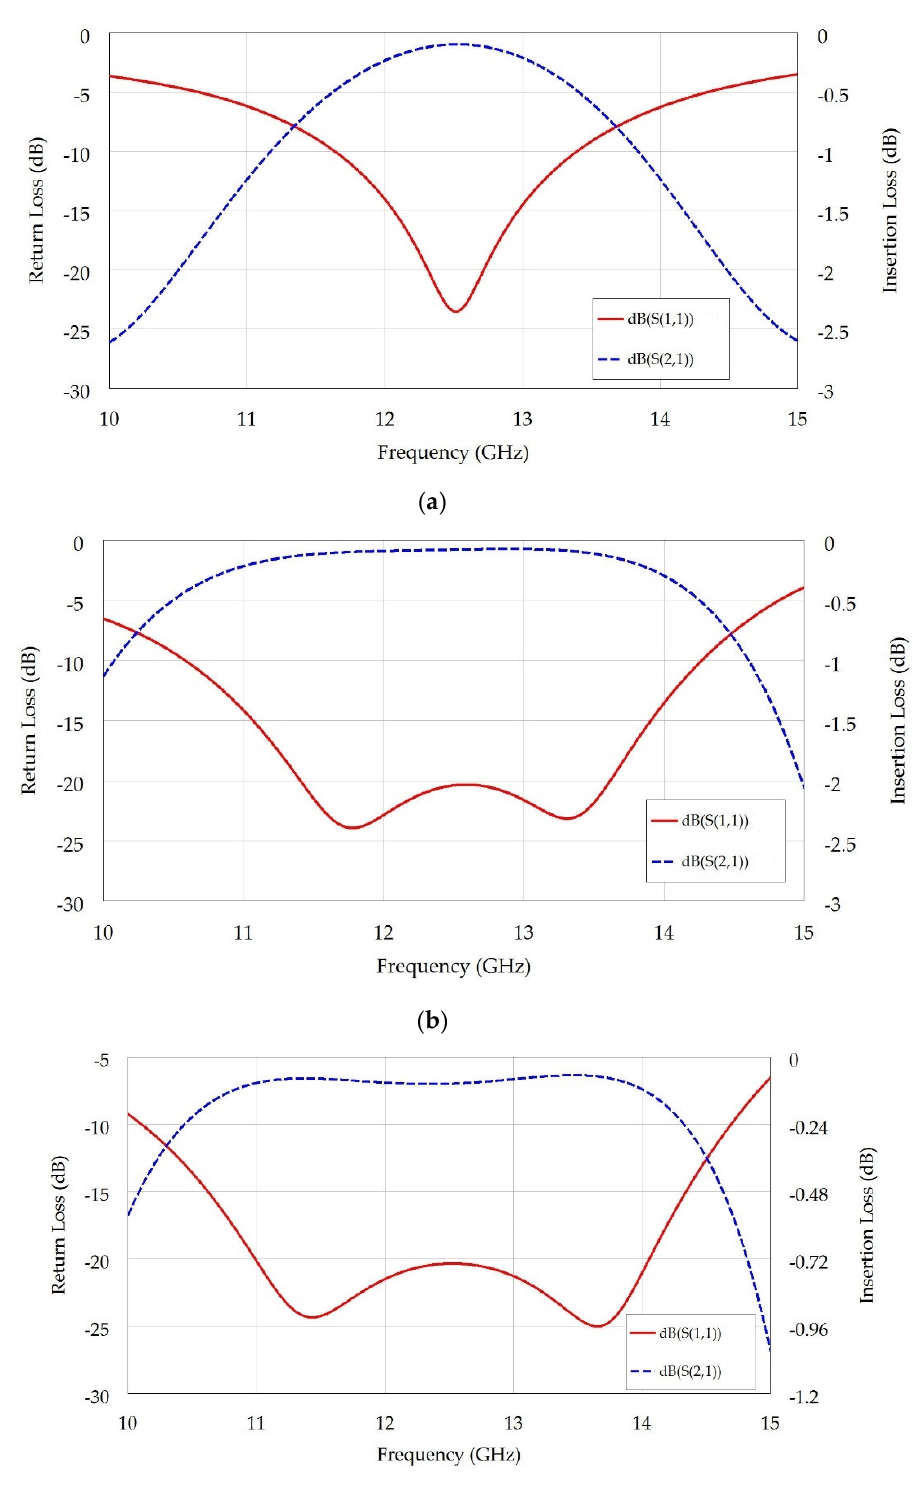
Figure 9. Full-wave simulated scattering parameters for three optimized matching networks. ( a ) One iris; ( b ) Two irises; ( c ) Three irises. The 20-dB return loss bandwidth improves with an increasing number of irises. Fractional bandwidths of 3.28%, 17.59%, and 24.51% were obtained in the three cases. Insertion loss was better than 0.2 dB and flatter in the frequency ranges corresponding to good input port matching.